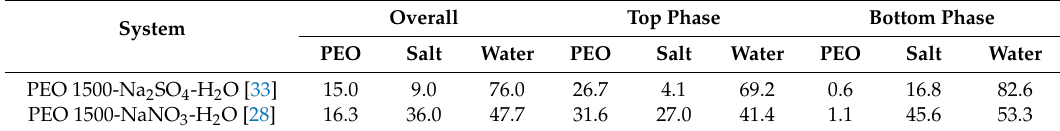
Table 1. The initial composition, the composition of the top and bottom phases for the system based on PEO 1500 and NaNO 3 and Na 2 SO 4 at 298.15 K (compositions in wt%) and ~100 kPa.